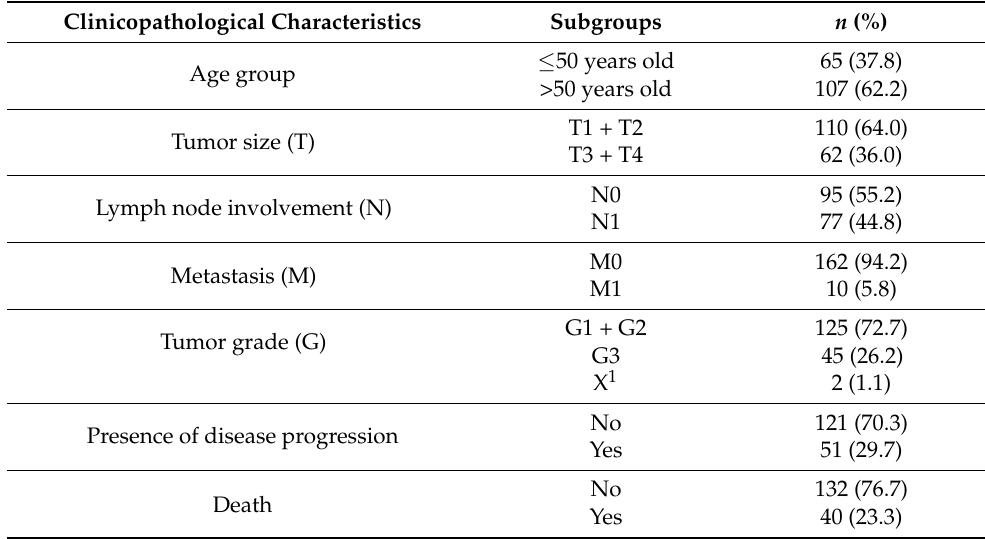
Table 2. Clinicopathological characteristics of the patients with cervical cancer ( n =